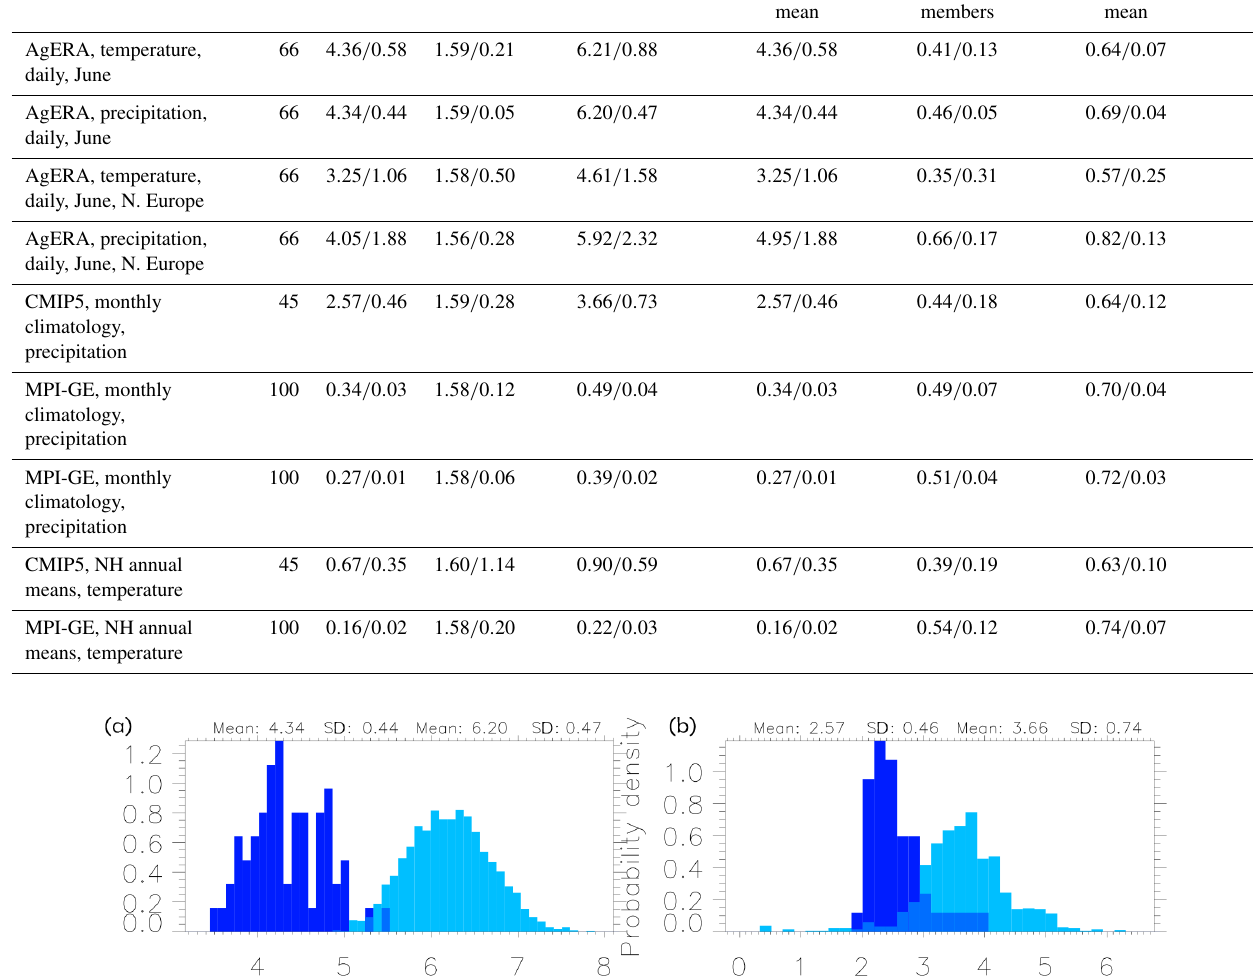
Table 2. Summary of the different measures. Entries show mean/standard deviation. Units are K for temperature and mmd − 1 for precipita- tion. No. of Lengths Angles Distances between Distances between Correlations Correlations between samples pairs of ensemble ensemble members between pairs ensemble members members and ensemble of ensemble